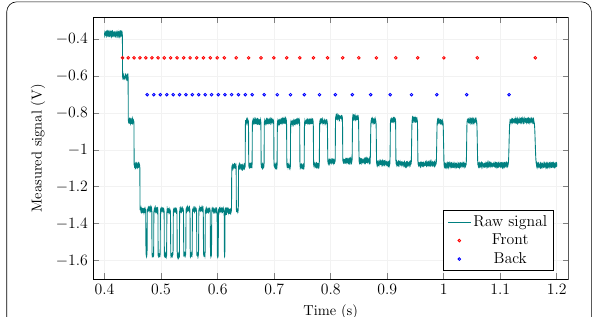
Fig. 8 The ideal curve fitted onto the measured data. Fig. 9 The measured signal on one frame for tracking the